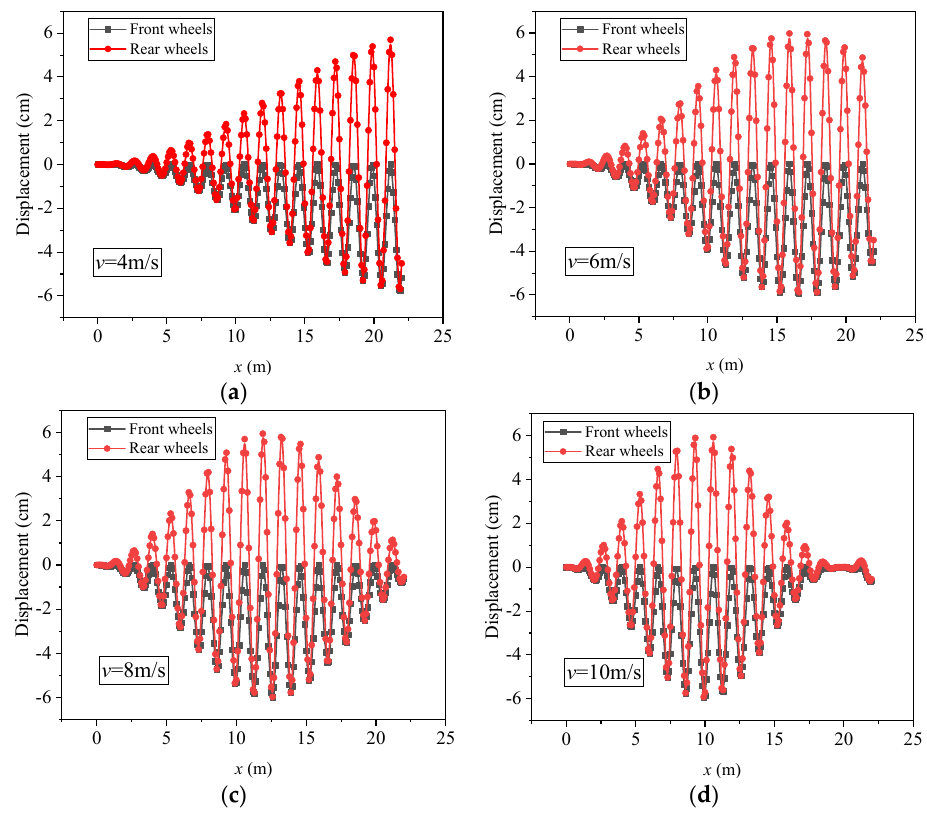
Figure 8. Net displacement of front and rear wheels 0 ≤ x ≤ ( b + c ): ( a ) v = 4 m/s; ( b ) 6 m/s; ( c ) 8 m/s; ( d ) 10 m/s.